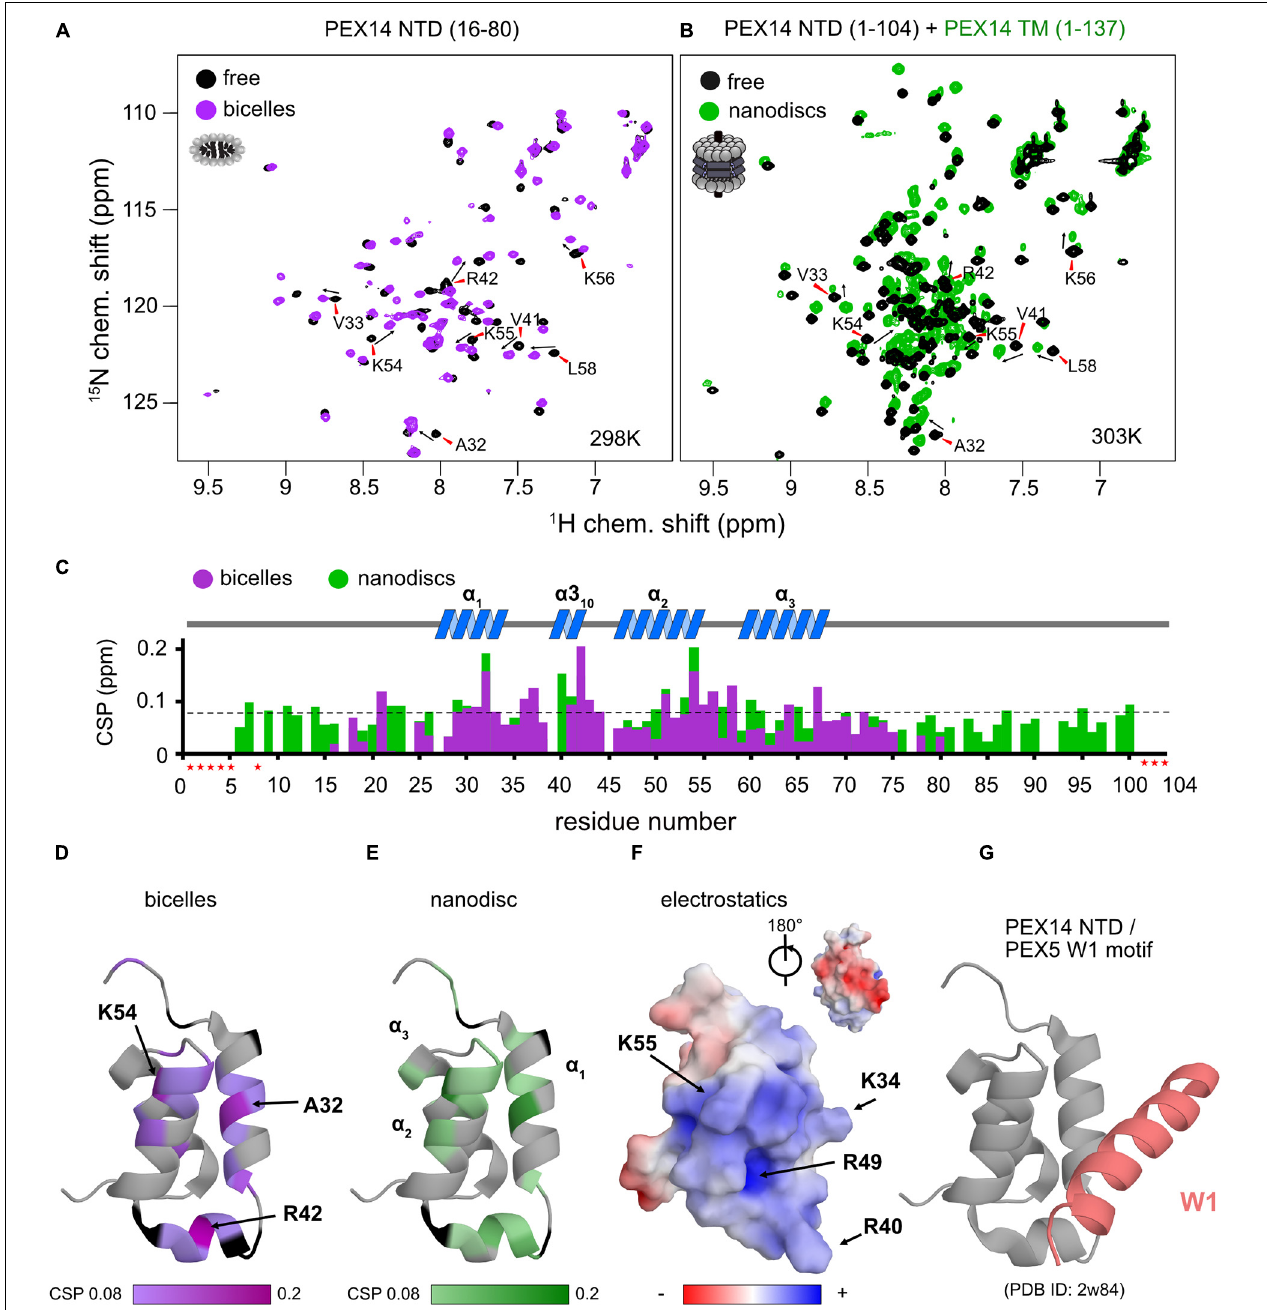
FIGURE 4 | The PEX14 NTD interacts with bicelles and nanodiscs. (A) 1 H, 15 N HSQC NMR spectra of the isolated NTD (16–80) in the absence (black) and presence of bicelles (1.1-fold molar excess, magenta). (B) Spectra of the extended PEX14 NTD (residues 1–104) in solution with the PEX14 TM (residues 1–137), anchored in nanodiscs. (C) Chemical shift perturbations vs. residue in the presence of bicelles (magenta) and nanodiscs (green). (D) Mapping of the CSPs shown in (C) in the presence of bicelles (D) and anchored to nanodiscs (E) onto the structure of the globular domain in the PEX14 NTD. Hotspots cluster around Ala32, Arg42, and Lys54. (F) The membrane binding interface is strongly positive charged due to the presence of Arg and Lys residues, as seen by electrostatic surface rendering. (G) The membrane binding surface partially overlaps with binding site of the PEX14 NTD with WxxxF/H motifs from the PEX5 NTD.